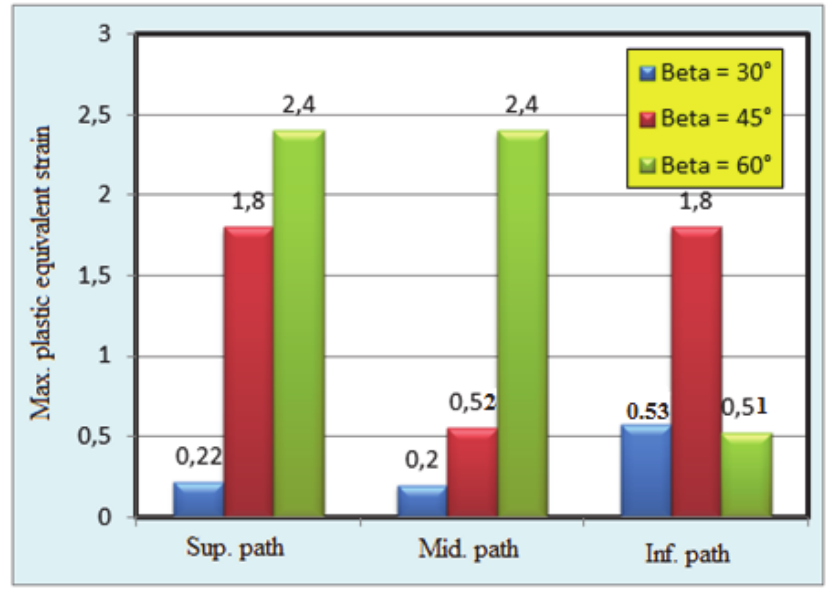
Figure 16: Evolution of maximum equivalent plastic deformations for different angles of the die